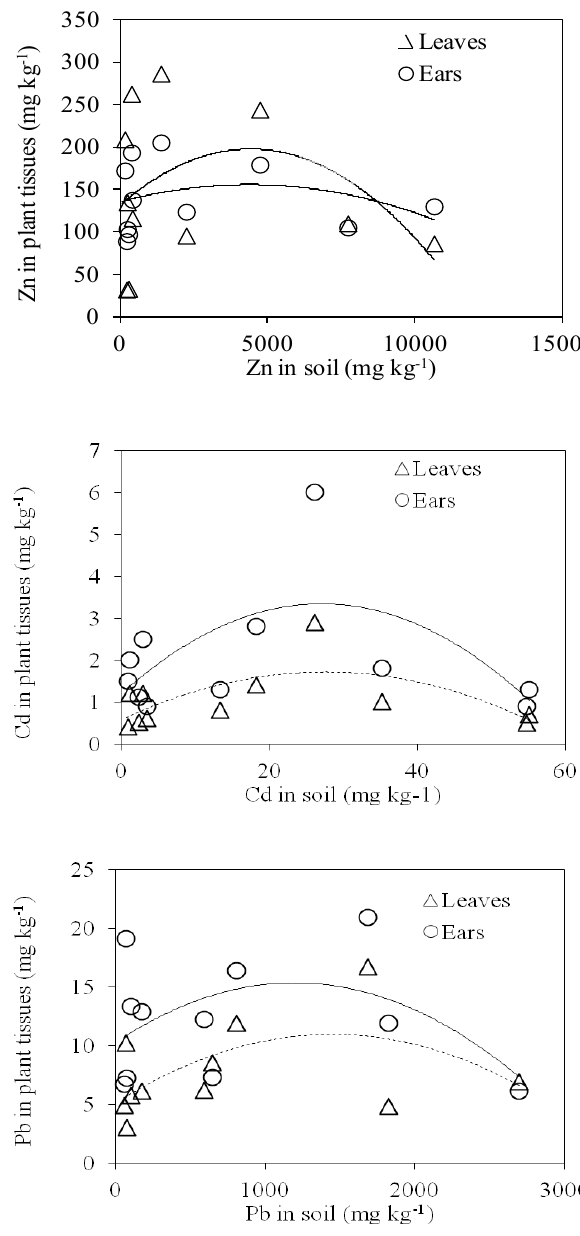
Figure 2: Correlation between the content of Zn (a), Cd (b) and Pb (c) in soils and plant tissues: leaves and ears of Molinia caerulea L. with polynomial fit (dashed lines represent leaves, solid ones -